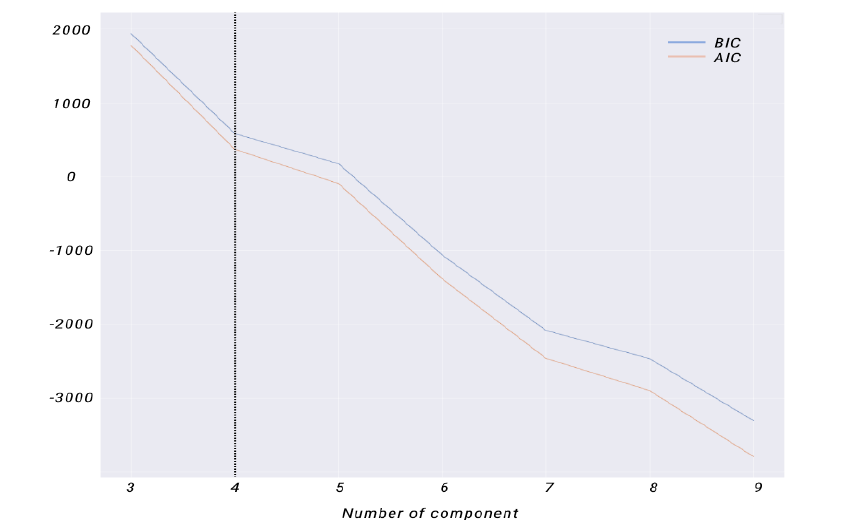
Figure 20. BIC and AIC graphs for three-dimensional inputs: Latitude , Longitude , SOG